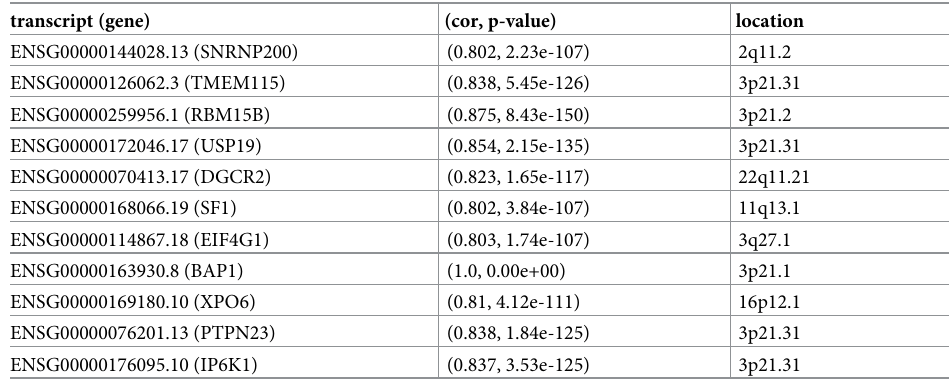
Table 6. Highly correlated genes with BAP1 in the entire COAD dataset.